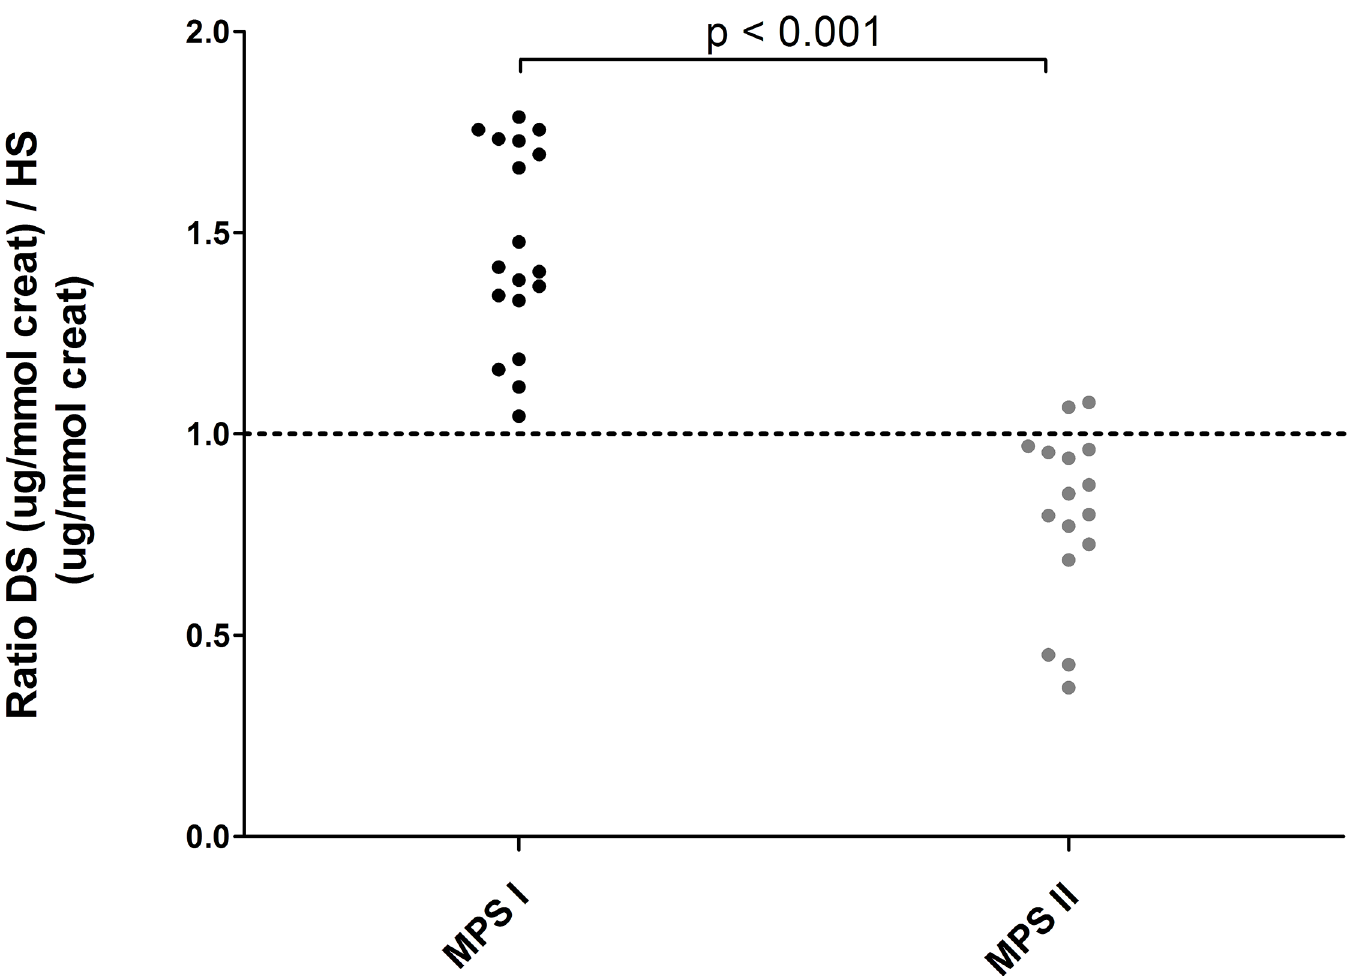
Fig 3. Ratio of the concentrations of DS and HS in MPS I and MPS II patients. In all MPS I patients a relatively high DS concentration (ratio > 1) was observed, opposed to relatively higher HS levels (ratio < 1) in MPS II